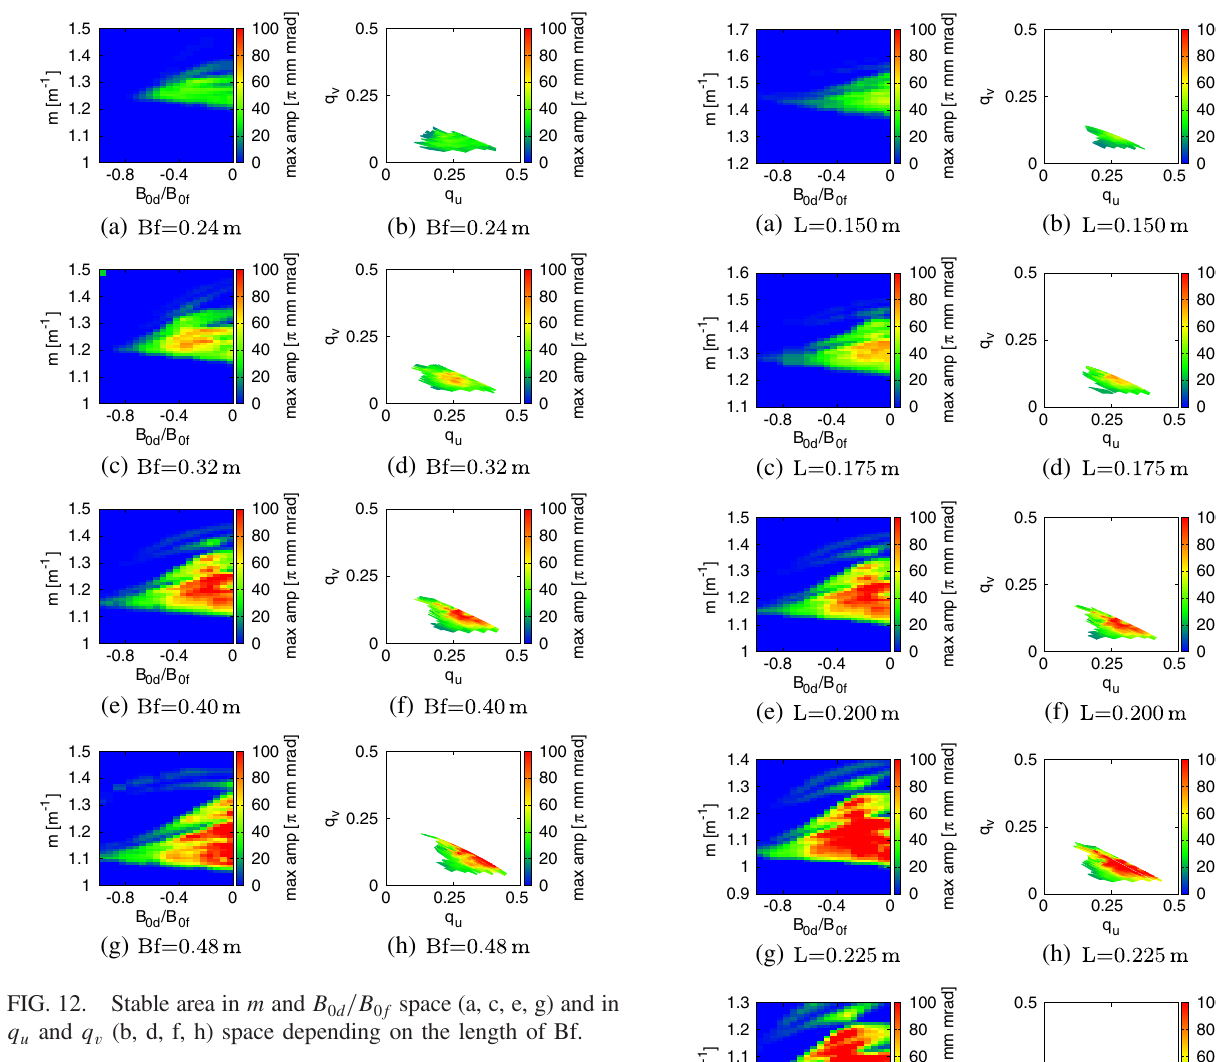
FIG. 12. Stable area in m and B 0 q and q (b, d, f, h) space depending on the length of Bf. u v